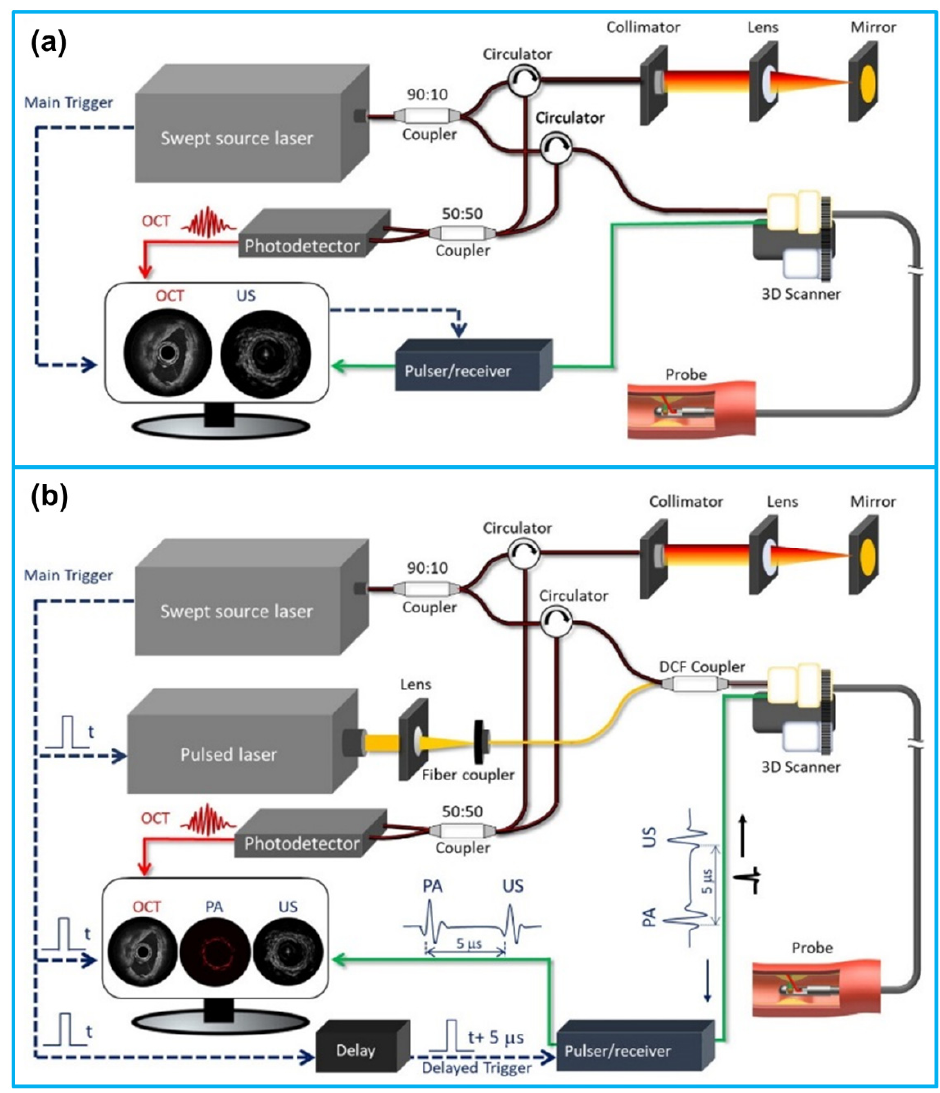
Figure 10. Schematic illustration of multi-modality intravascular imaging systems. ( a ) Dual-modality IVUS-OCT imaging system; ( b ) tri-modality IVUS-OCT-IVPA imaging system. Reprinted from [184] with permission. Table 9. A summary of different combined intravascular imaging modalities for the assessment of vulnerable plaque.